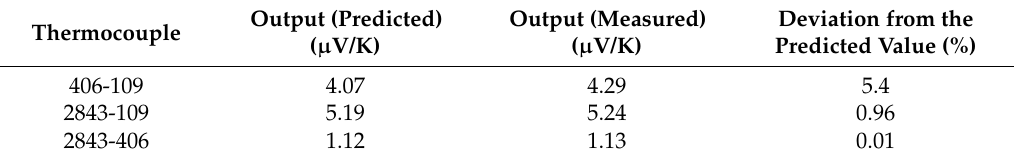
Table 3. Comparison of predicted and measured output voltages per Kelvin.